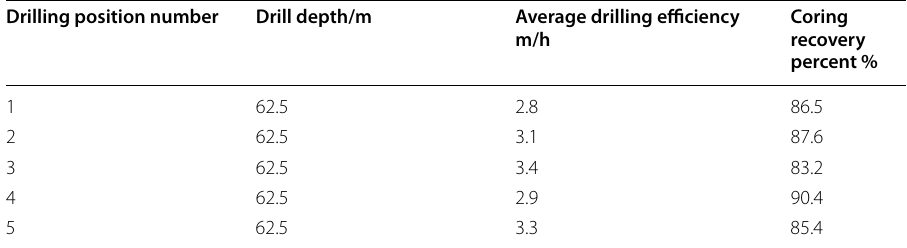
Table 3 Drilling operation log sheet Drilling position